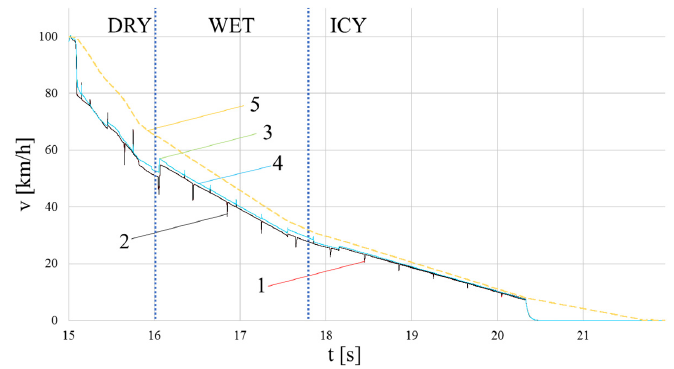
Figure 12. Braking on a straight road with dry–wet–icy surfaces profile speed curves: 1—FL wheel velocity, 2—FR wheel velocity, 3—RL wheel velocity, 4—RR wheel velocity, 5—vehicle velocity.